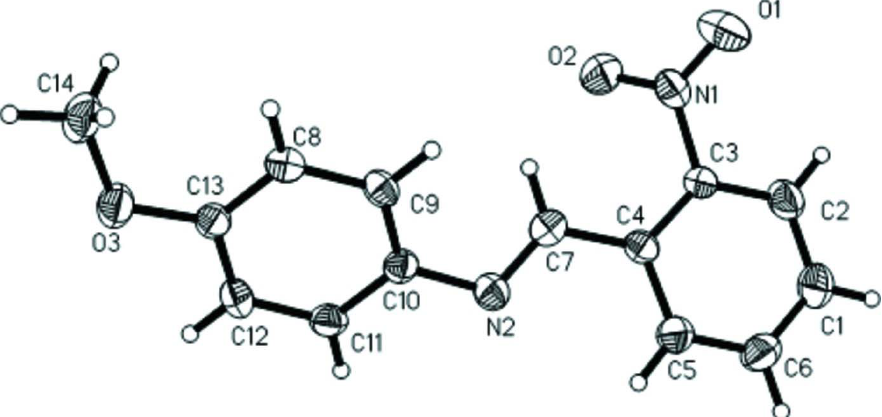
The molecular structure of the title compound with the atom-labeling scheme. Displacement ellipsoids are drawn at the 30% probability